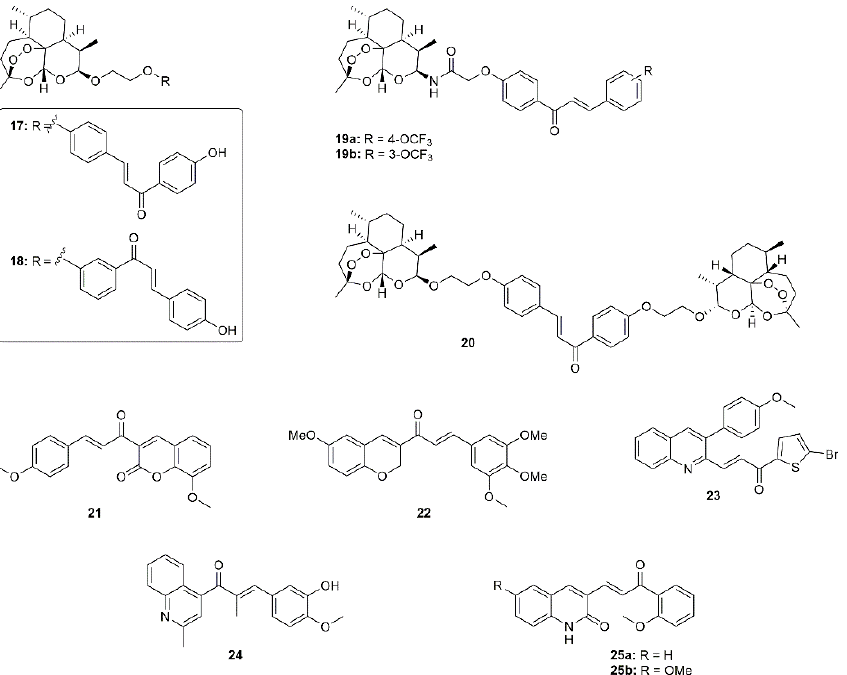
Figure 2. Structures of artemisinin-, coumarin- and quinoline-chalcone hybrids 17 – 25 with anticancer activity.